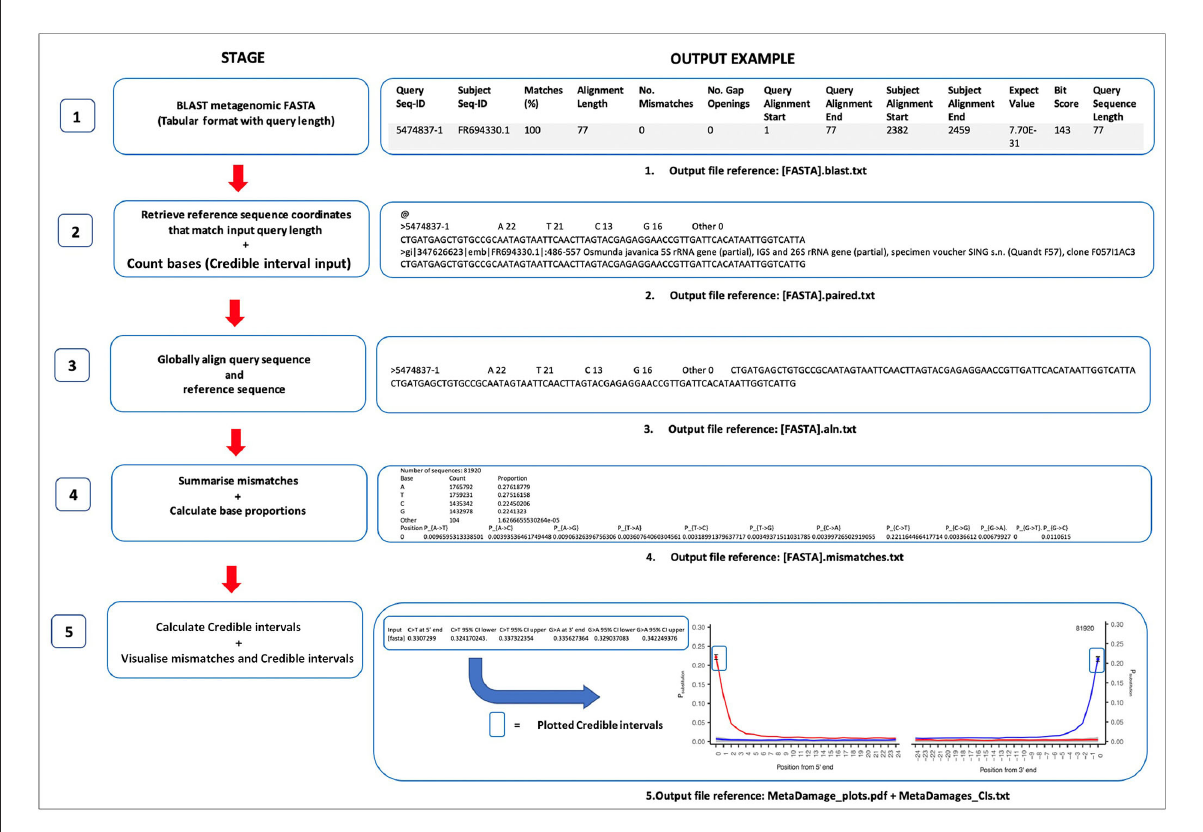
FIGURE1 Stages of the MetaDamage tool, including the Credible Interval